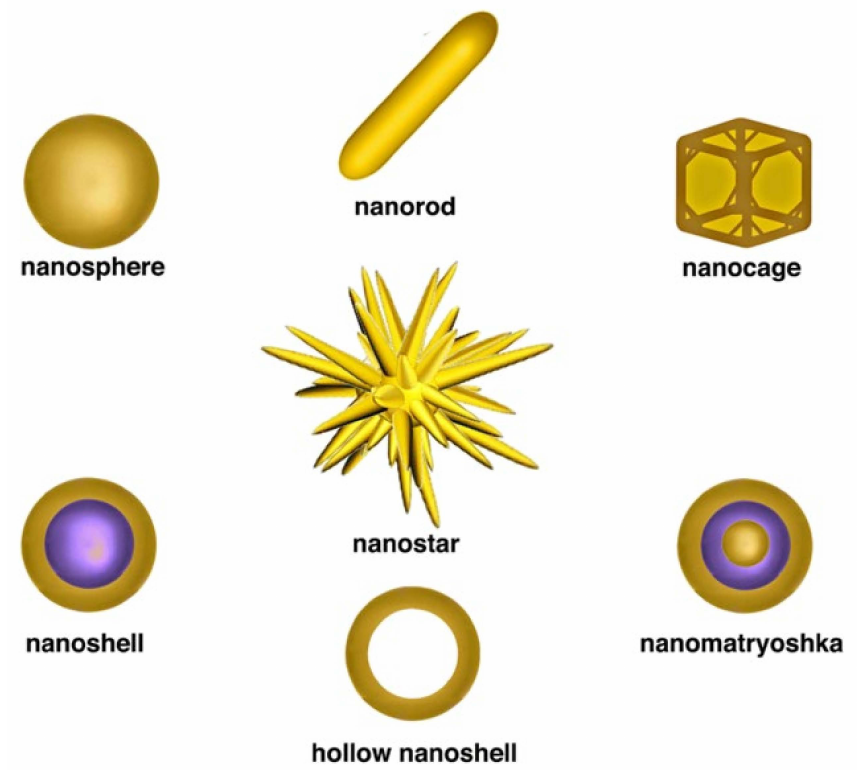
Figure 1. Different shapes of gold nanomaterials. The figure is reprinted from Berardis et al. (2021) [35]. This study is under Creative Commons Attribution 4.0 International License, which per- mits use, sharing, adaptation, distribution, and reproduction in any medium or format, as long as you give appropriate credit to the original author(s) and the source as well as provide a link to the Creative Commons license (http://creativecommons.org/licenses/by/4.0/, accessed on 26 May